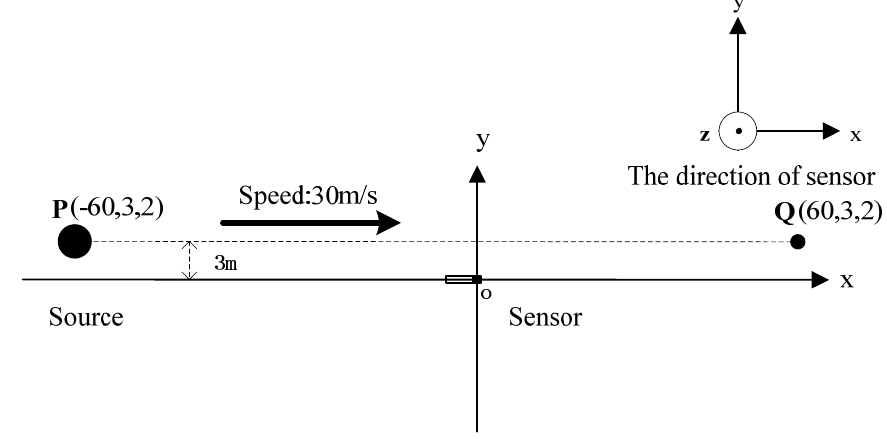
Figure 3. Overhead view of the position between the radiation source and magnetic sensor.